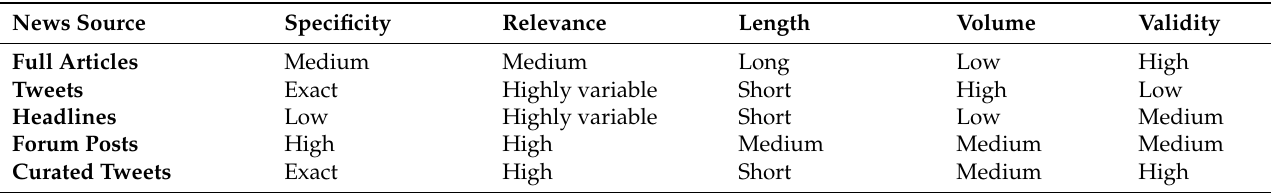
Table 2. Comparison Between News Article